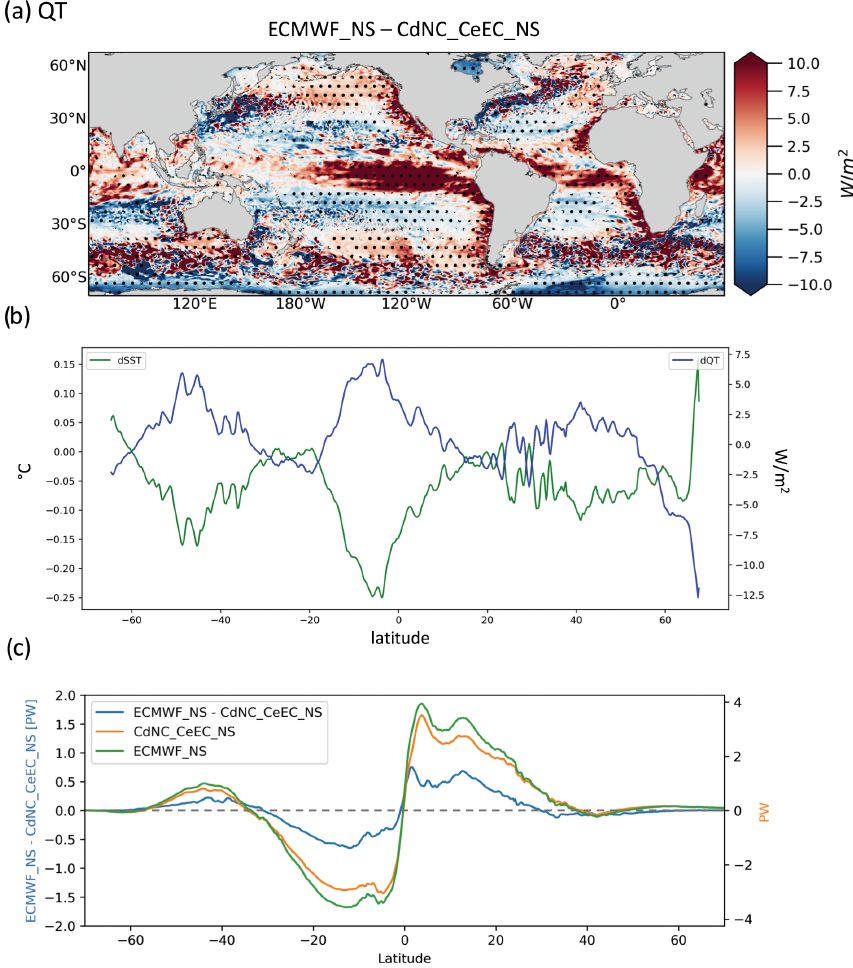
Figure 11. (a) Annual mean differences in turbulent heat fluxes ( Q T ) between ECMWF_NS and CdNC_CeEC_NS . (b) Time series of annual zonal-mean differences in SST (green) and Q T (blue) between ECMWF_NS and CdNC_CeEC_NS . (c) Global meridional heat transport in the upper 100m of the ocean (values on the right y axis) for ECMWF_NS and CdNC_CeEC_NS and differences (values on the left y axis) between them. Hatching indicates significant values (95% confidence